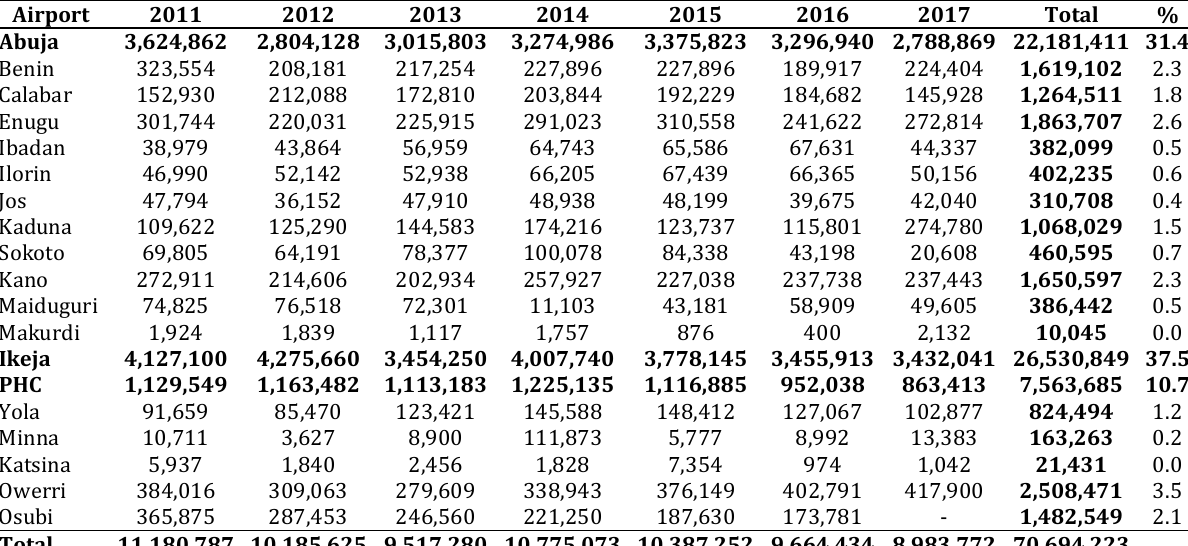
Table 1: Passenger traffic at domestic airports in Nigeria from 2011 to